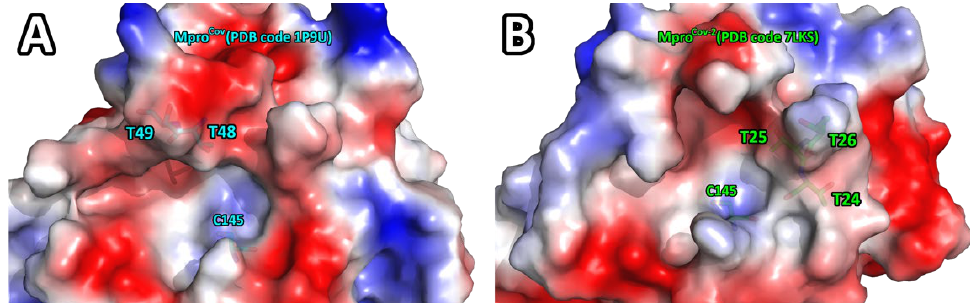
Figure 2. Three-dimensional depiction of the Mpro CoV ( A ) and Mpro CoV-2 ( B ) catalytic sites. The enzyme surfaces are represented as a “solvent accessible surface”, in which the partial charges of the residue atoms are colored in blue or in red, accordingly with their positive or negative charge. Residues are numbered as in the X-ray structures.